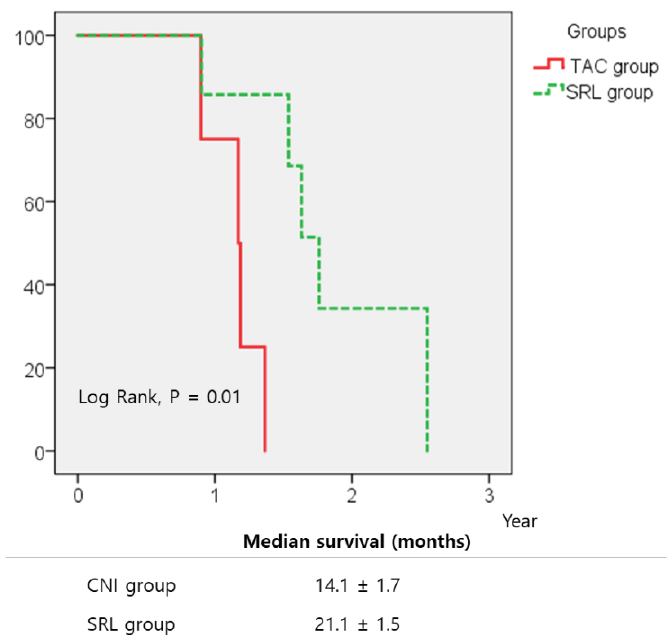
Figure 3. Tumour-bearing survival after recurrence in 13 recurred cases. Early initiation of sirolimus (SRL) at 1 month after living-donor liver transplantation significantly prolonged survival after recurrence compared with tacrolimus (TAC) ( p = 0.01).